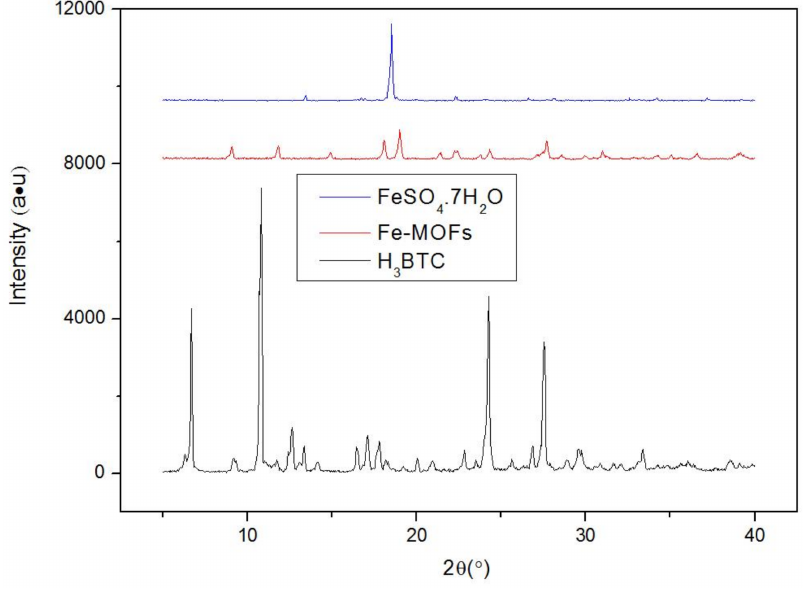
Figure 1. XRD of Fe-based metal-organic frameworks